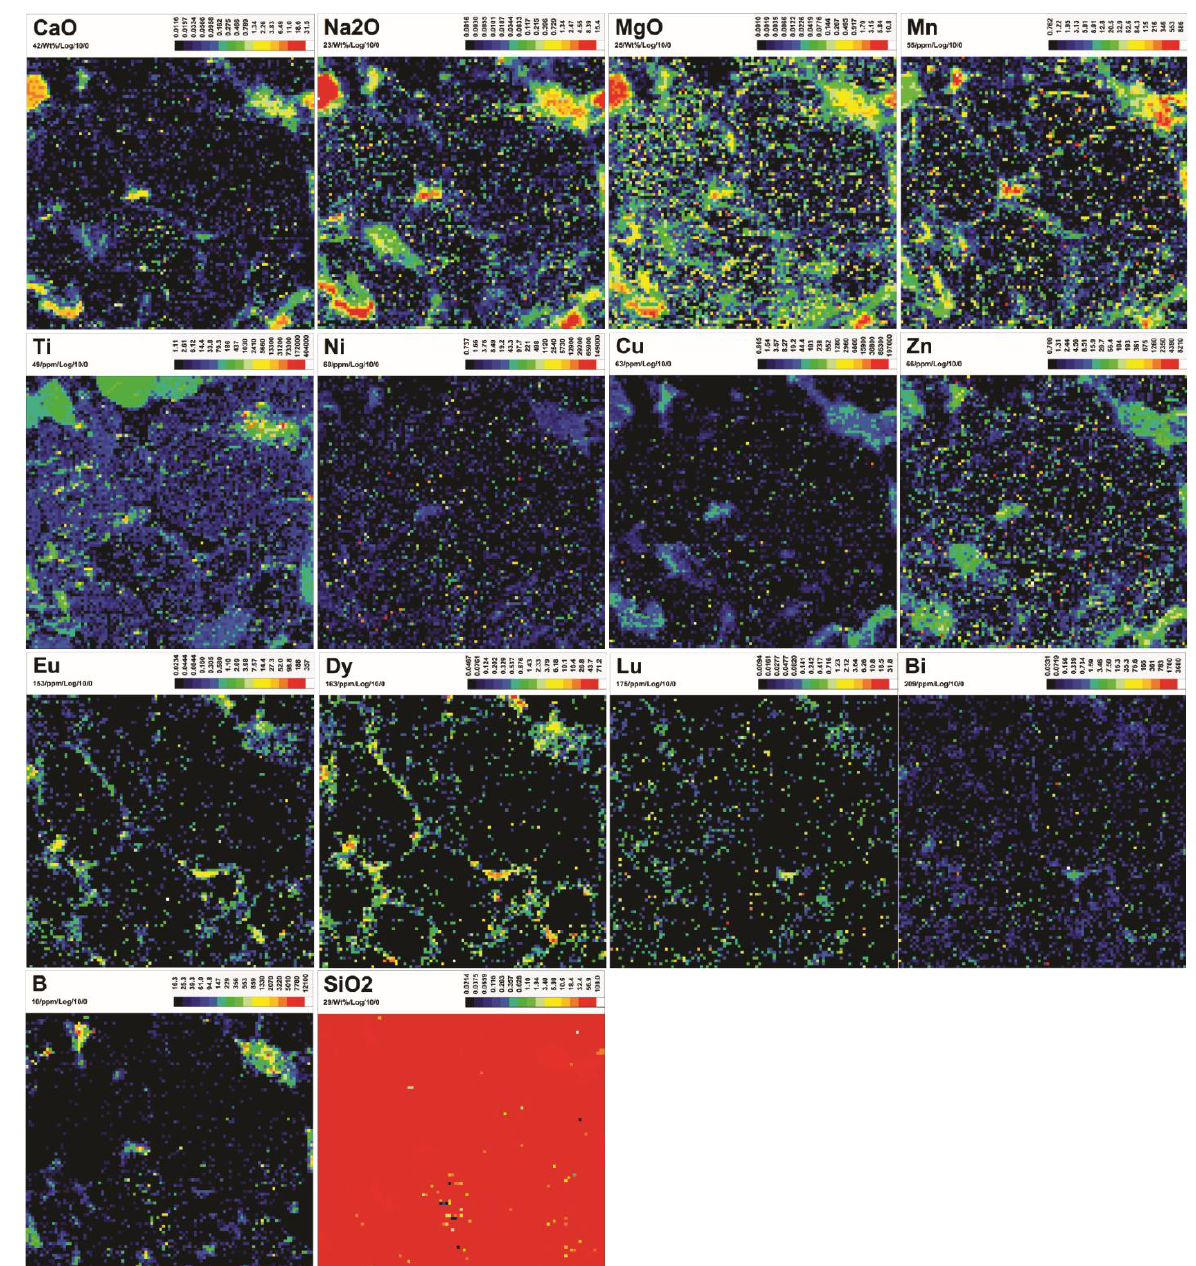
Figure 4. LA-ICP-MS mapping of elements that are moderately to weakly enriched in the matrix and quartz rim of the sandstone sample (#1425) shown in Figure 2, except SiO 2 , which dominates the whole sample.